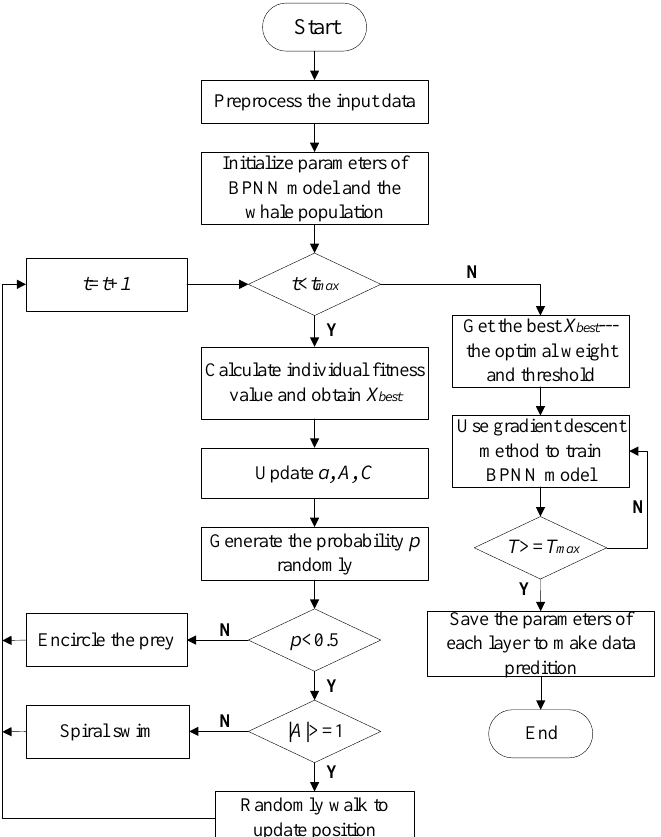
Figure 2. The calibration model of WOA-BPNN.